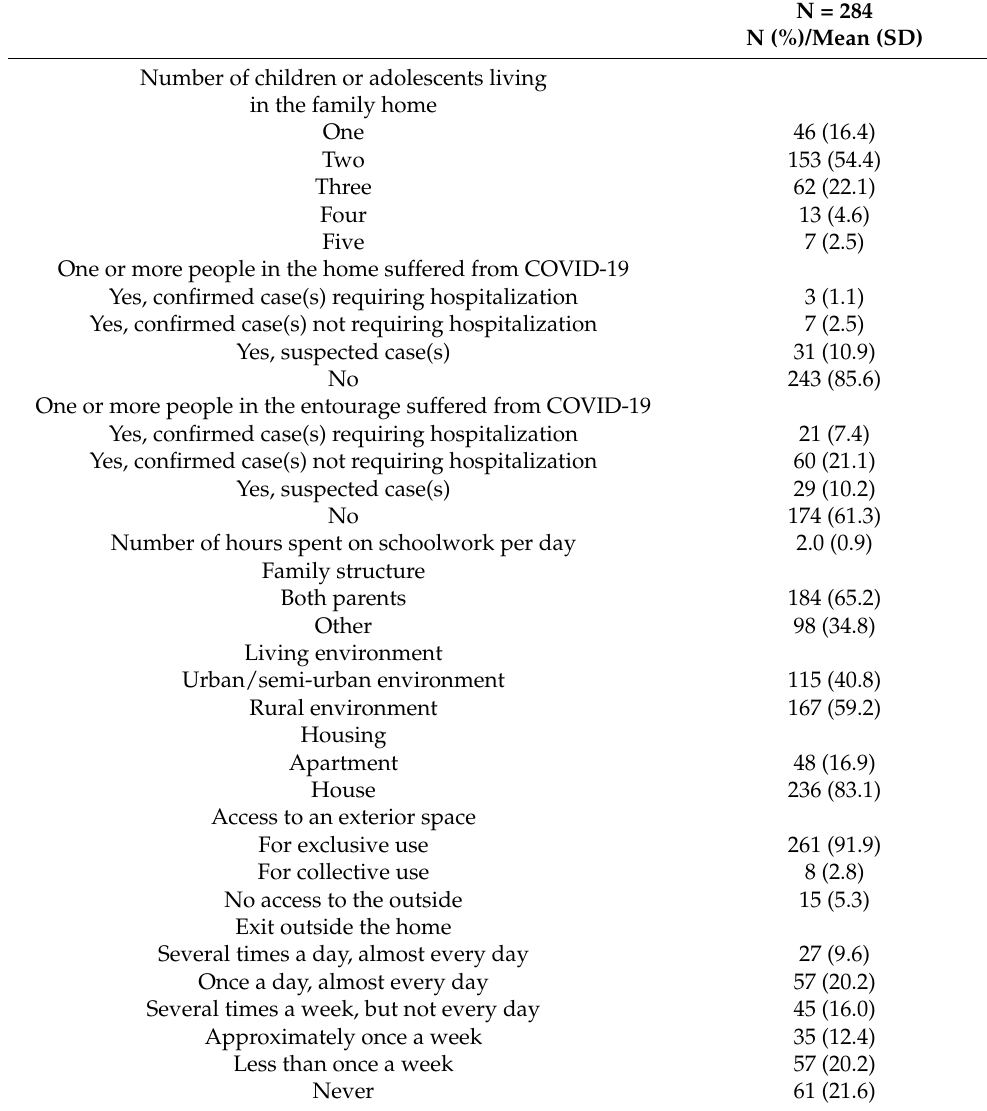
Table 2. Sociodemographic, living, and learning characteristics of the adolescent sample population during lockdown (N =